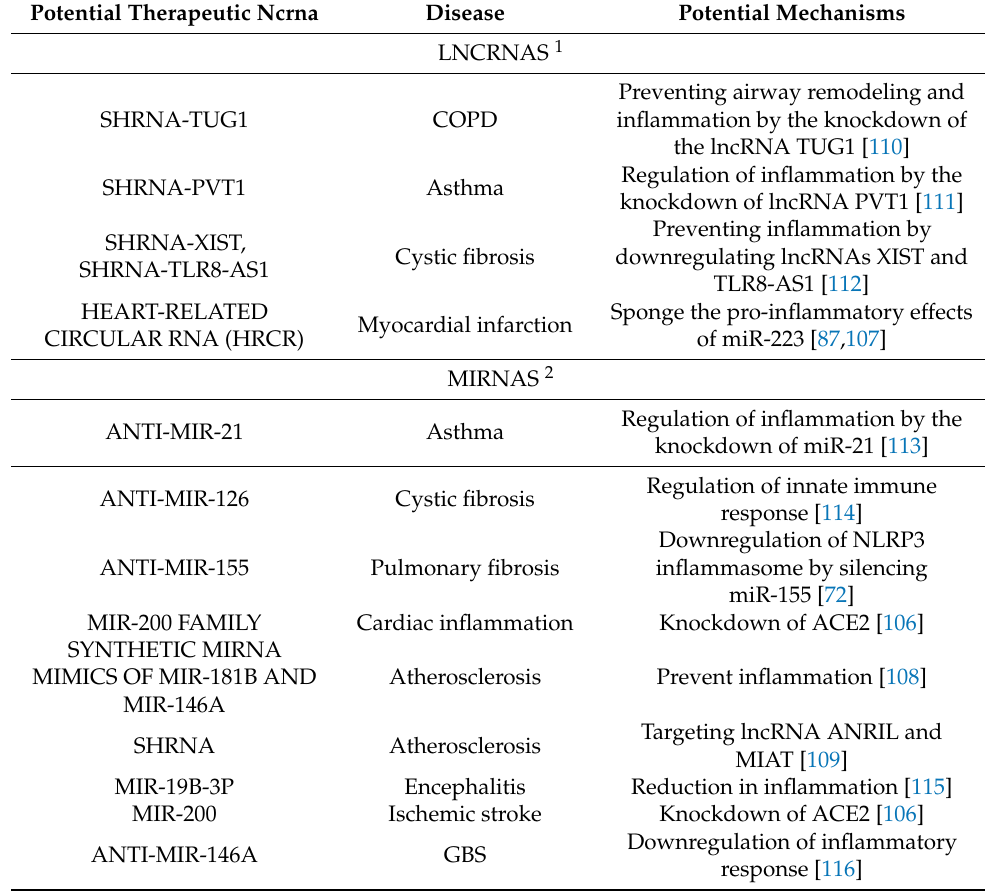
Table 1. The therapeutic potential of ncRNAs in different diseases and the mechanisms